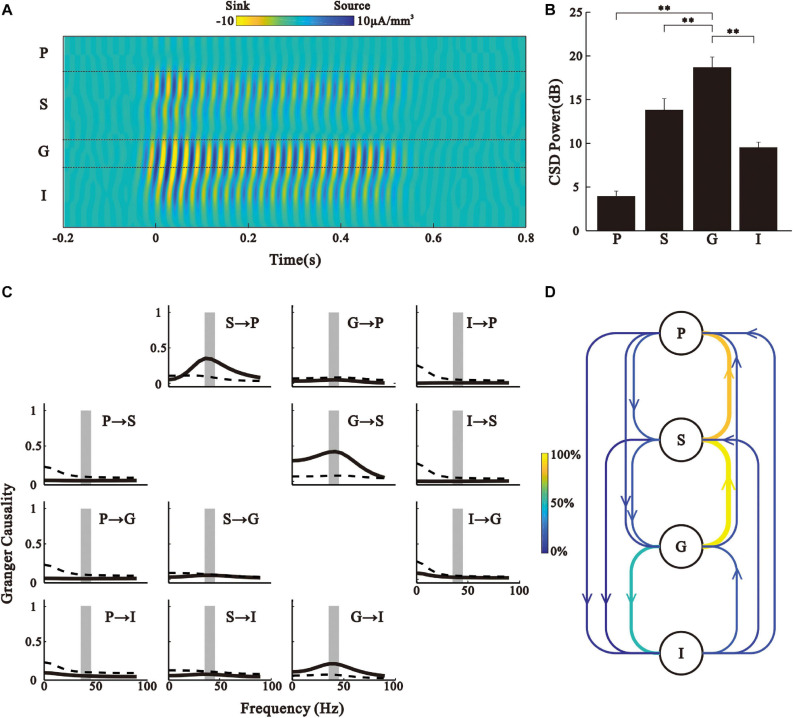
CSD analysis. (A) Laminar map of 35–45 Hz CSD driven by 40 Hz click-train for the example in Figure 1. (B) Bar graph shows the mean and SE of CSD power during 0.2–0.5 s post-stimulus time window. ∗∗p < 0.01, Kruskal–Wallis test followed by Tukey’s multiple comparison. (C) Granger causality spectra for different layer pairs for the example in Figure 1. The y-axis is the target and x-axis is the driver (i.e., panel xy, where x is the row index of the panel and y is the column index, shows the Granger causality spectrum for x- > y). Solid line is the Granger causality spectrum. Dashed line shows the threshold level of statistical significance (p < 0.01, random permutation approach). Vertical shaded strip marks the frequency band of 35–45 Hz. (D) Schematic representation of directional information flow between different layers. Color of an arrow represents the percentage of significant Granger causality observed in all the recorded trials.